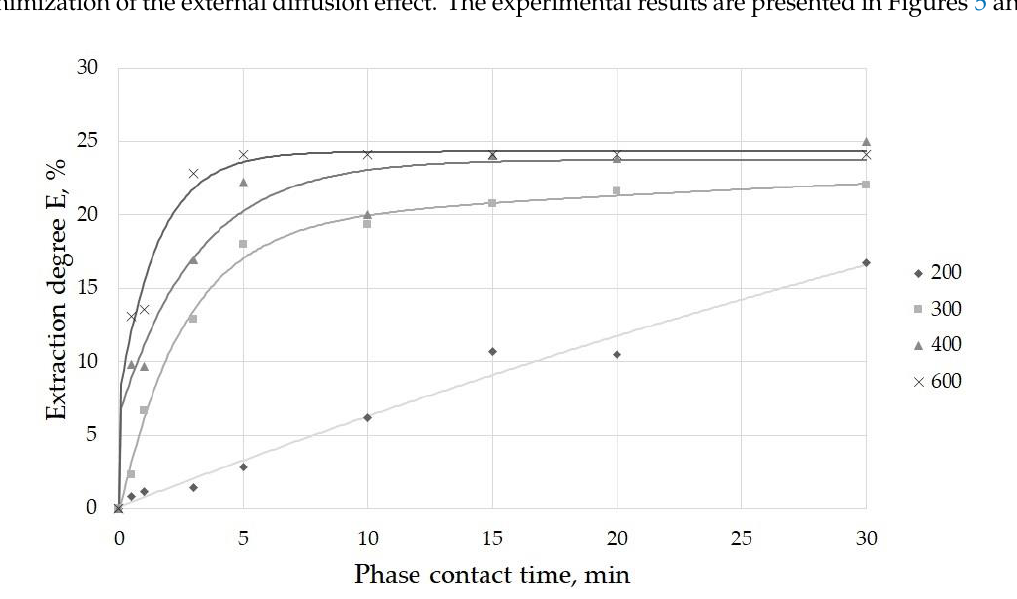
Figure 5. The dependences of the iron (III) extraction degree on the phase contact time at different stirring rates under a temperature of 300 K.